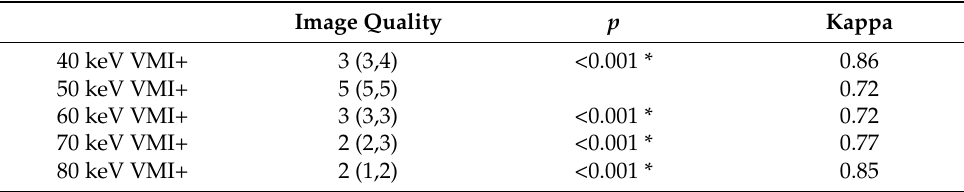
Table 4. Subjective analysis of the main abdominal organs in different VMI+.